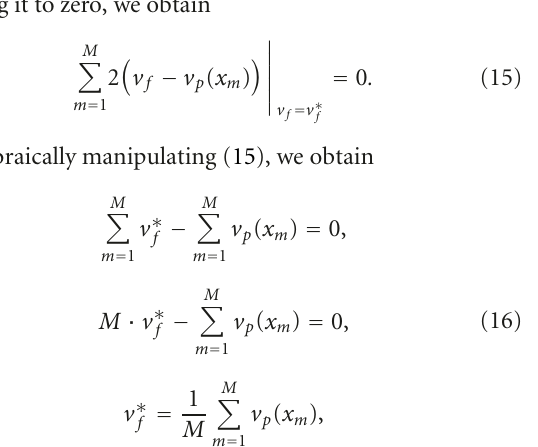
Figure 7: Entropy values within the interval [0 . 3 v sim , 2 v sim ].